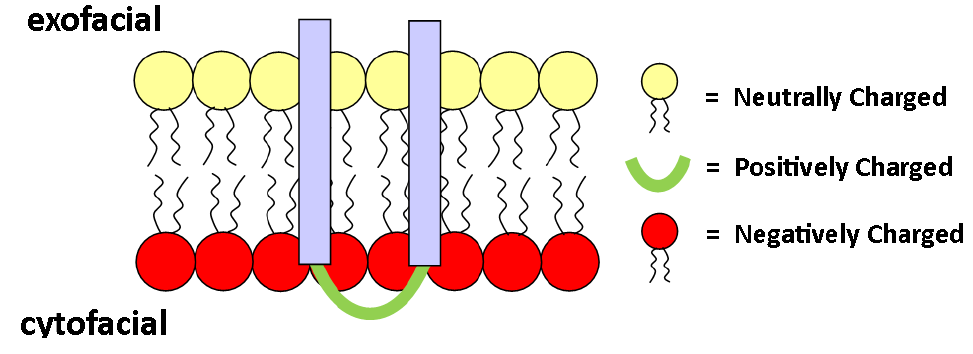
Figure 7. Schematic of an integral protein orienting itself according to electrostatic attraction between positive domains on the protein and negatively-charged lipids on the inner